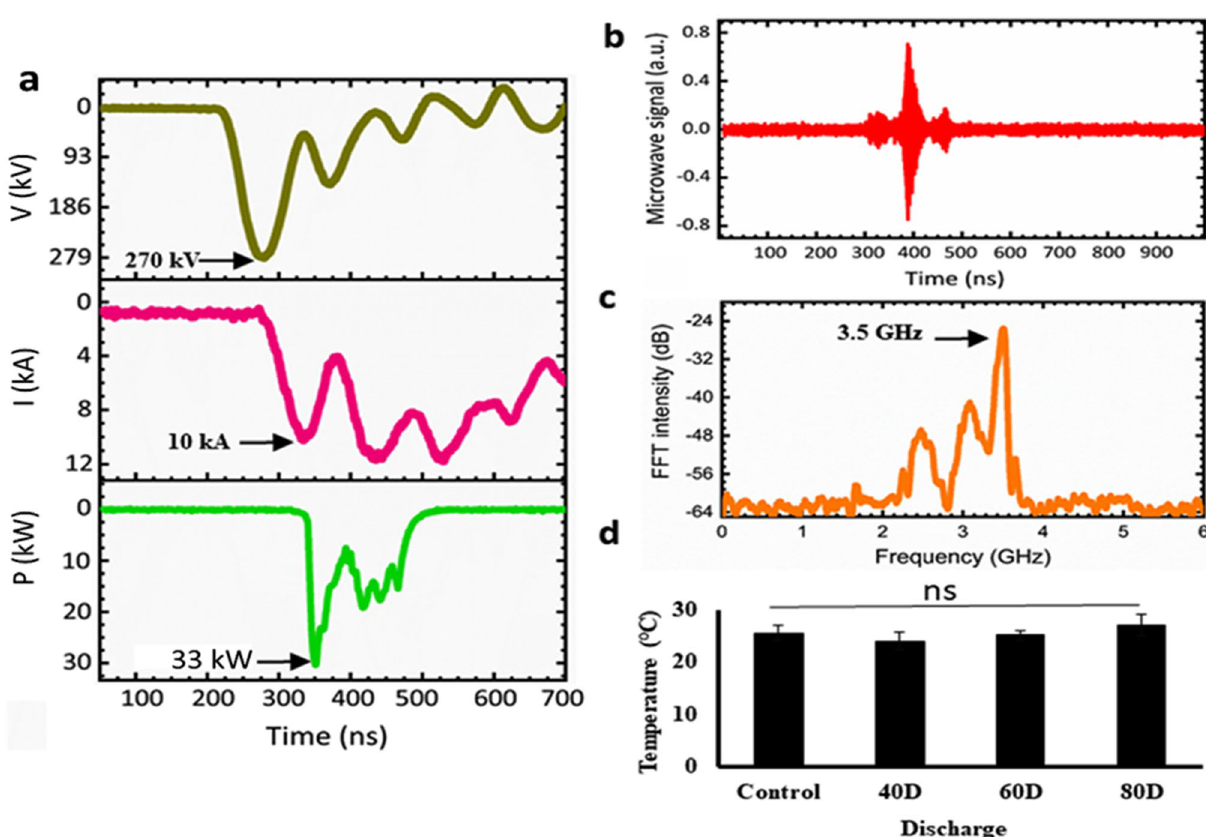
Figure 2. Physical characteristics of the PMR apparatus. ( a ) Typical waveform of the diode voltage, diode current, and microwave envelope signals, ( b ) microwave signal, ( c ) dominant frequency of the microwaves, and ( d ) temperatures of the saline after the different PMW exposure (the room temperature was 25